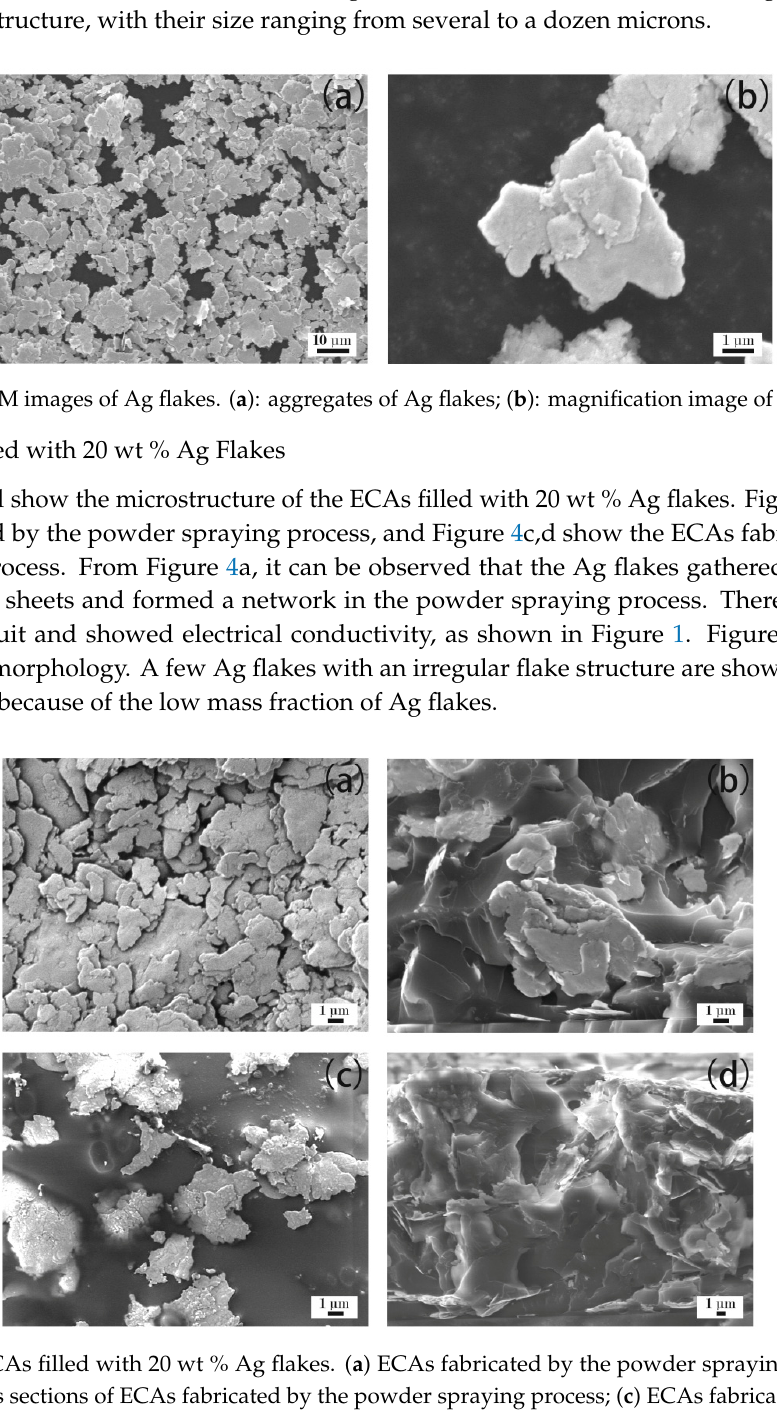
Figure 2. Lap shear strength of the ECAs fabricated by the powder spraying process and the conventional process.